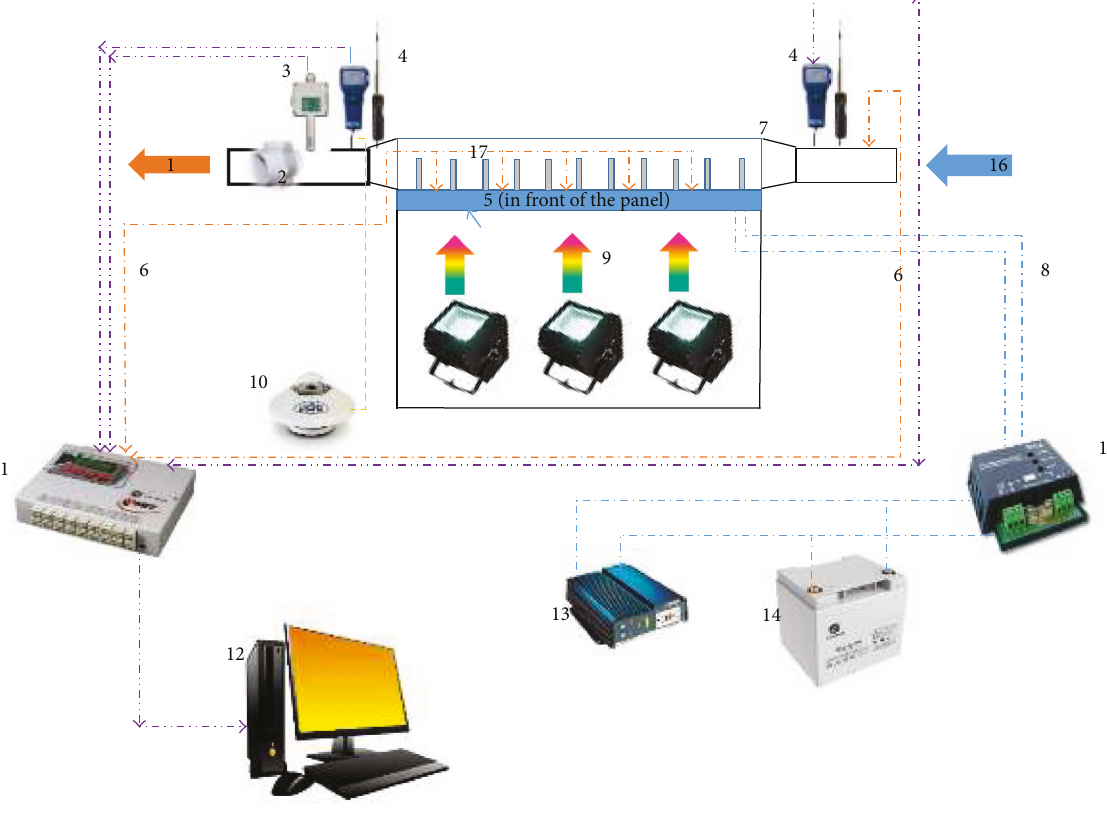
Figure 4: Experimental schematic setup.